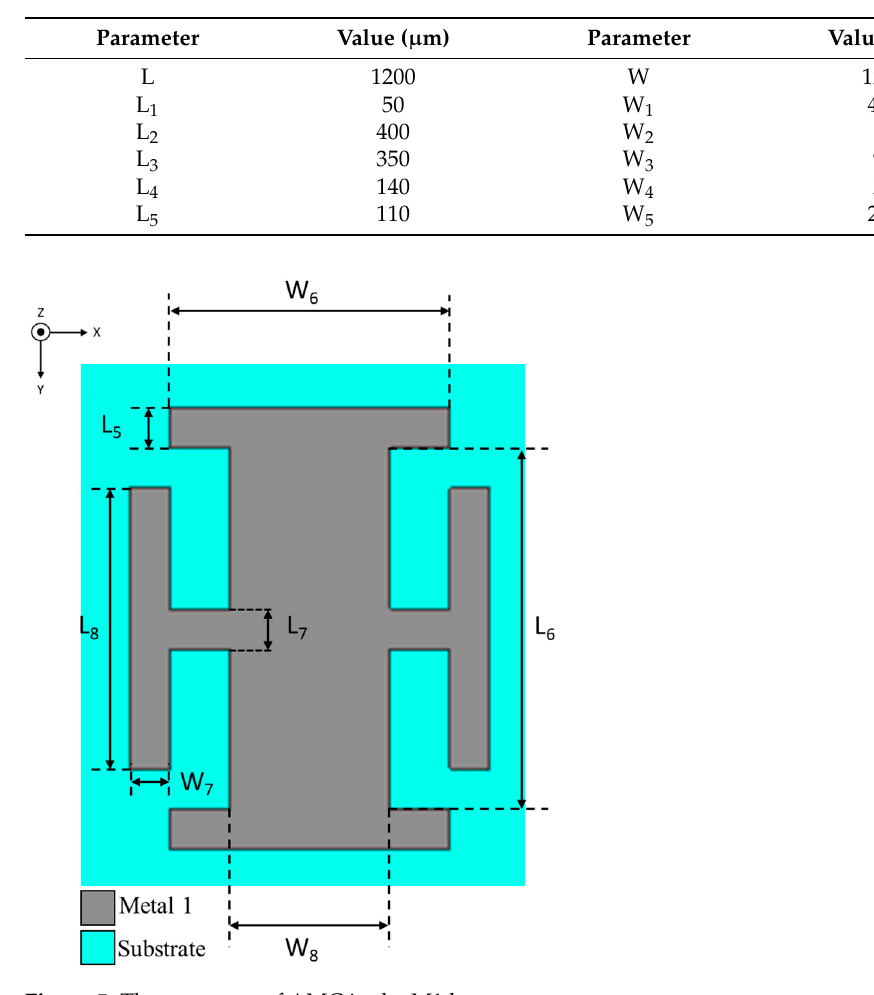
Figure 5. The geometry of AMC in the M1 layer.